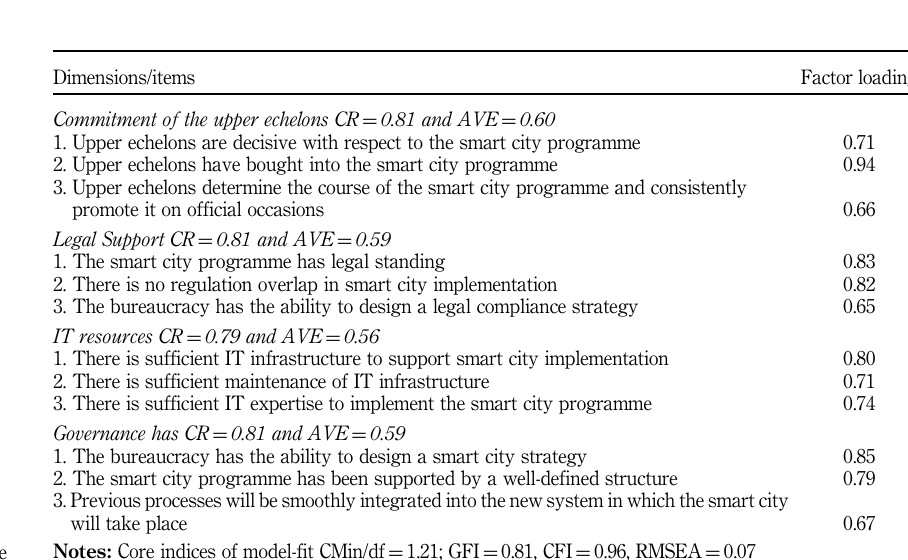
Figure 3. Item purification model with factor loading of each item